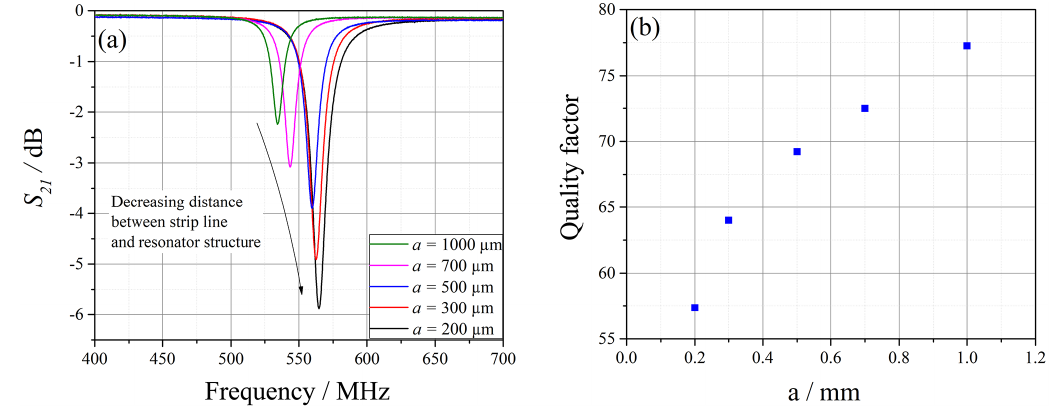
Figure 16. Increasing coupling by decreasing distance between strip line and resonator structure: (a) transmission measurement; (b) quality